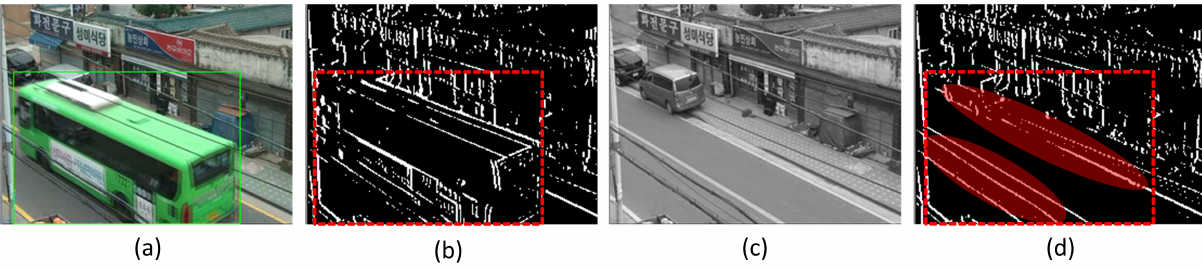
Figure 2. Difference of edge pixels between current and background frames due to scene dynamics: ( a ) current image; ( b ) current edge image; ( c ) background image; ( d ) background edge